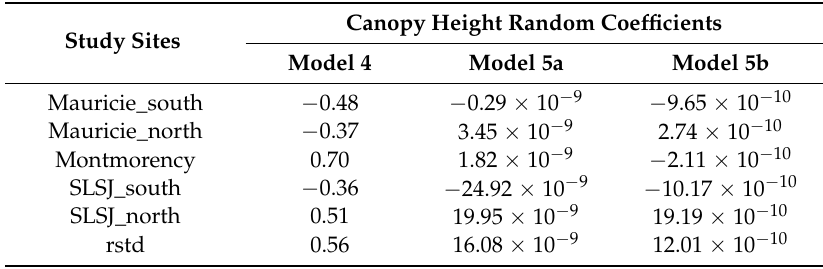
Table 6. Canopy height random coefficients of candidate merchantable volume